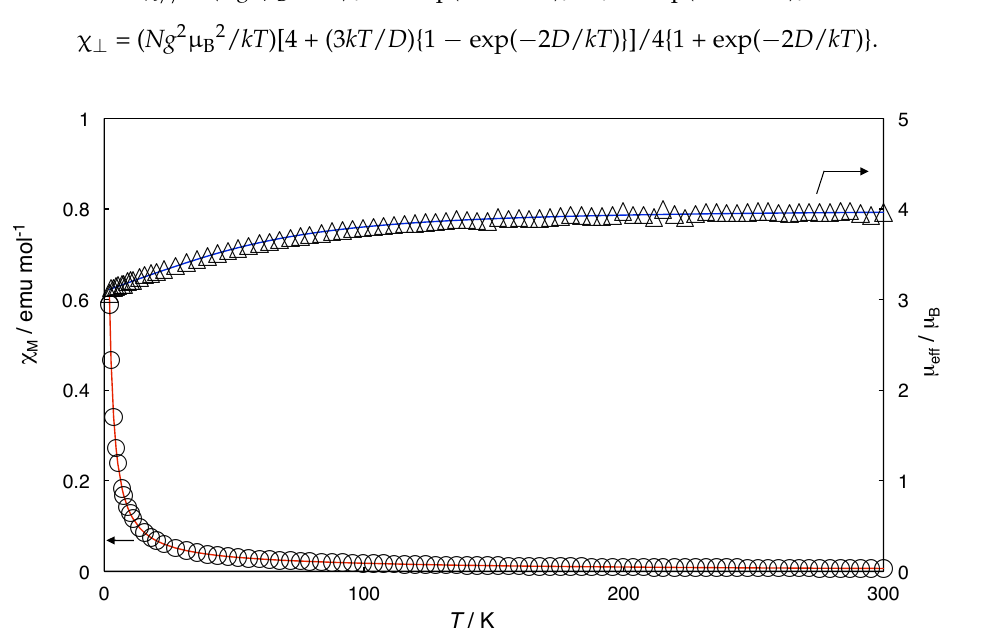
Figure 5. Temperature dependences of magnetic susceptibility χ M (circles) and moment µ eff (triangles) for [Ru 2 (O 2 CC 3 C 7 ) 4 Cl] n ( 1 ). The red and blue solid lines were calculated and drawn with the parameter values described in the